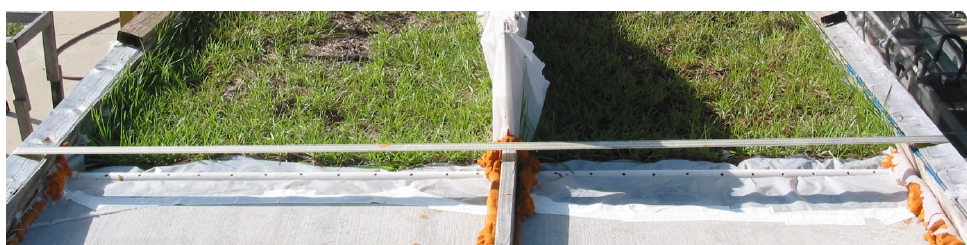
Figure 5. Perforated PVC pipe used for influent